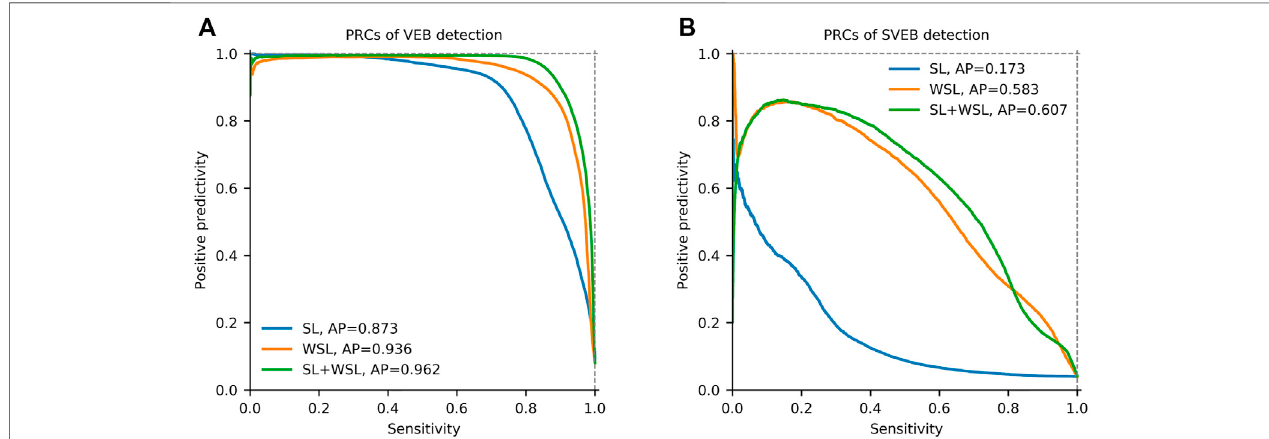
FIGURE 5 | Precision-recall curves (PRCs) of the detection for ventricular ectopic beats (VEB) and supraventricular ectopic beats (SVEB) on the total dataset in differentlearningsettings. (A) PRCsofVEBdetection. (B) PRCsofSVEBdetection.SL=supervisedlearning.WSL=weaklysupervisedlearning.AP=averageprecision.